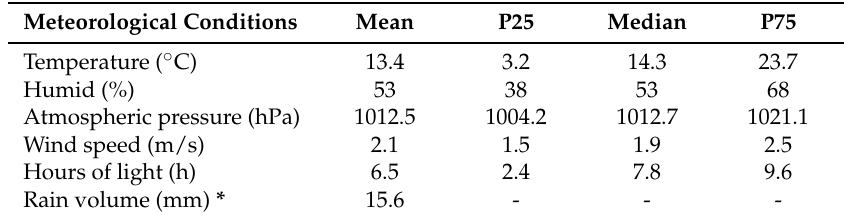
Table 2. Meteorological conditions in Beijing.